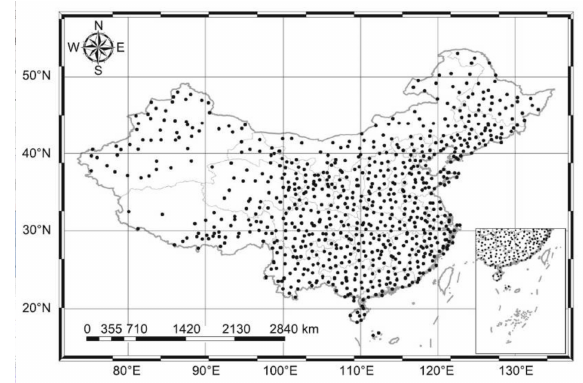
Figure 1. Chinese meteorological stations used in this